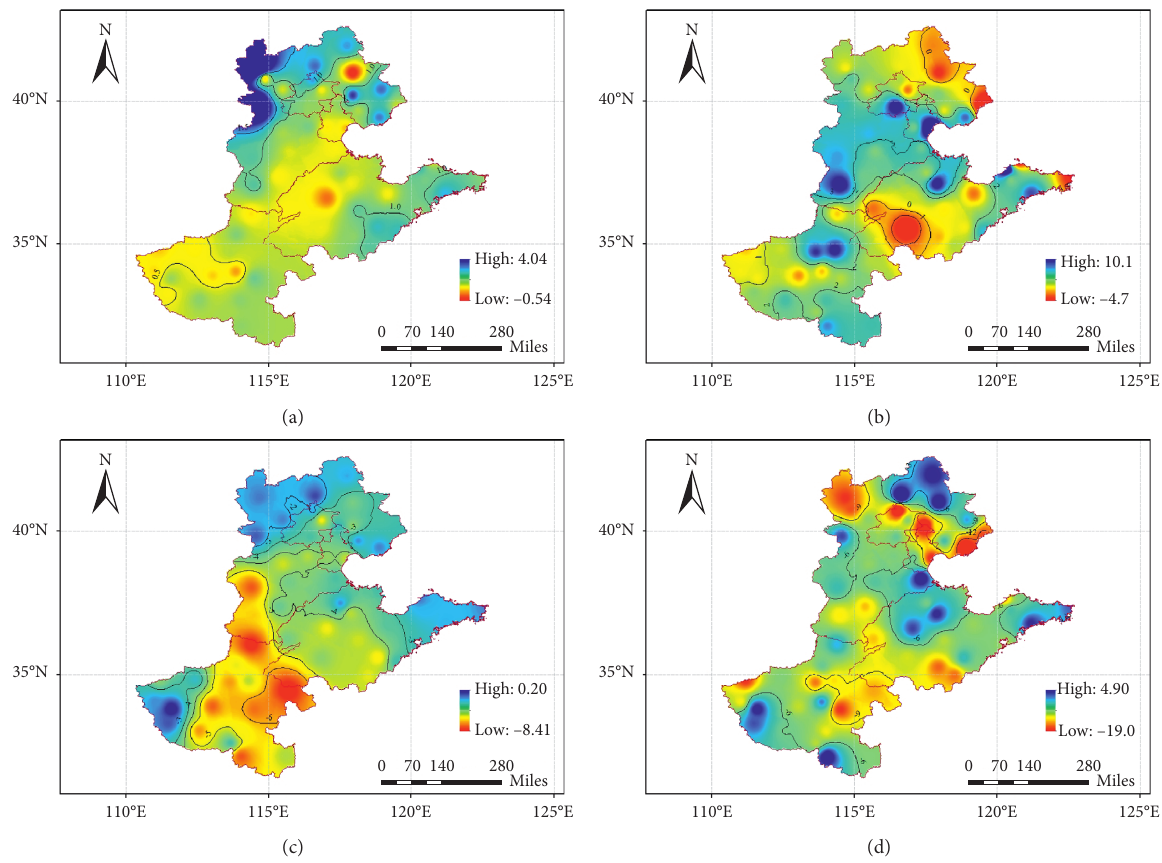
Figure 5: Spatial distribution of attribution rate to ET 0 of the main meteorological elements from 1961 to 2014. (a) Temperature. (b) Relative humidity. (c) Sunshine hours. (d) Wind speed.